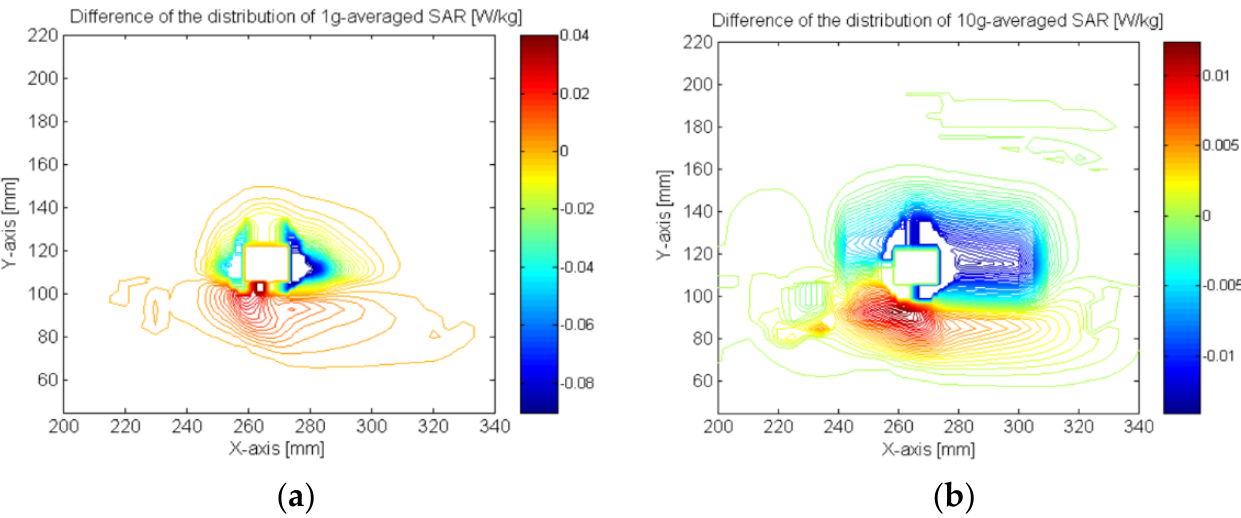
Figure 7. ( a ) Difference of the distribution of 1 g averaged SAR between two levels of conductivity: 20% increase and original at the frequency of 800 MHz with X orientation; ( b ) difference of the distribution of 10 g averaged SAR between two levels of conductivity: 20% increase and original at the frequency of 800 MHz with X orientation [84].